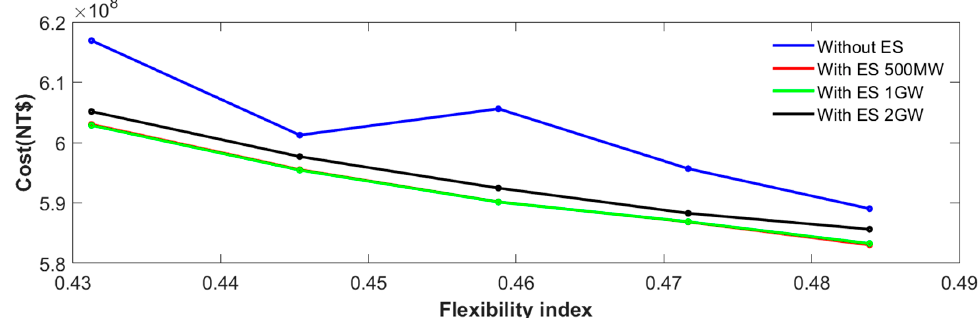
Figure 17. Relationship between multi-scenario unit-scheduling cost and generation flexibility in winter.